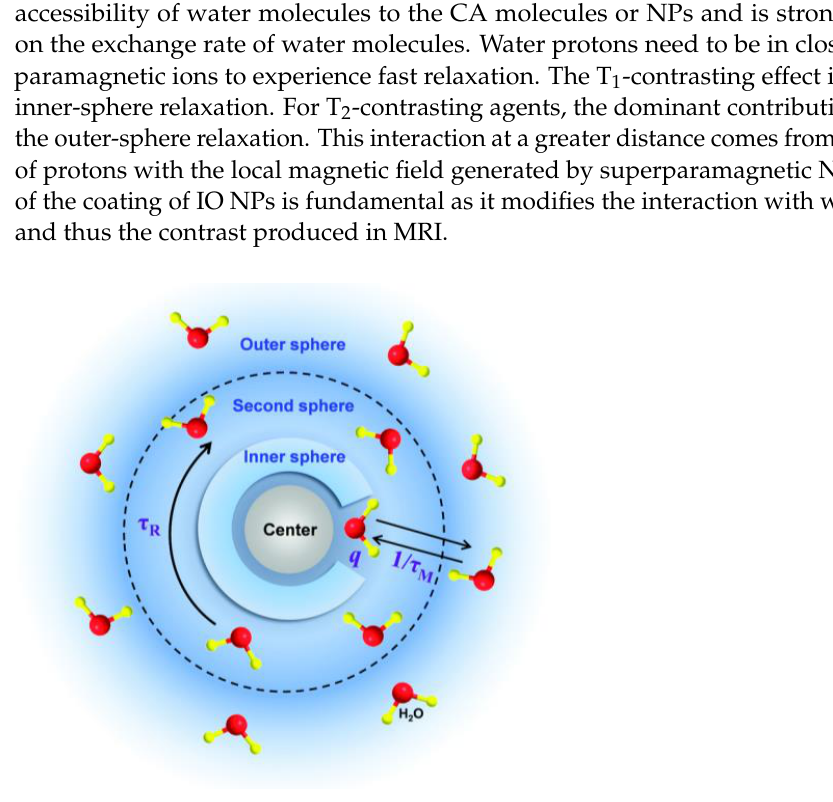
Figure 10. The inner sphere and outer sphere can influence the relaxation rates of MRI CAs [132]. Reprinted with permission from [132].